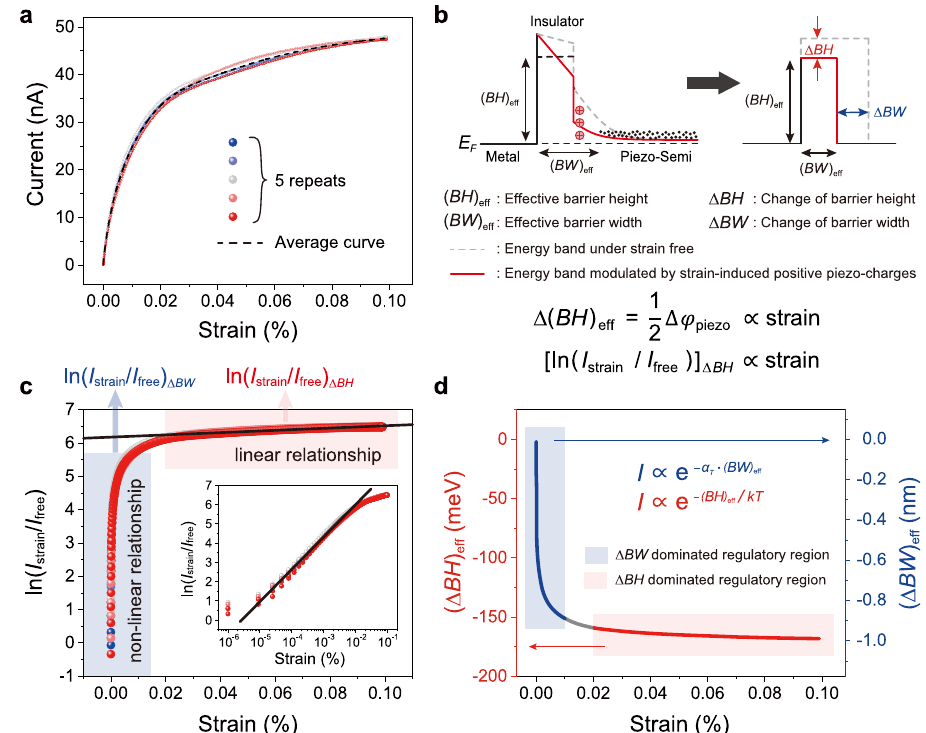
Fig. 3 Piezotronic modi fi cation on the tunneling barrier height and width. a Five cycles of current response to continuously changed tensile strain. The currents fi rst increase rapidly and then slowly with increasing strain. b Energy band pro fi le of tunneling junction. The metal/insulator/piezoelectric semiconductor tunneling barrier equivalent to a rectangular barrier, whose effective height and width are (BH) eff and (BW) eff , respectively, and their corresponding strain-induced changes are denoted as ( Δ BH) eff and ( Δ BW) eff . The part in ln( I strain / I free ) that has a linear relationship with strain is induced by the change of barrier height ( Δ BH) eff . c ln( I strain / I free ) as a function of strain. The regions that change drastically (blue region, strain <0.01%) and slowly (red region, strain >0.02%) with strain correspond to different dominant mechanisms: the former is dominated by ( Δ BW) eff , and the latter is dominated by ( Δ BH) eff , both of which caused by the piezotronic effect. d Change of the effective barrier height and width derived from c as a function of applied